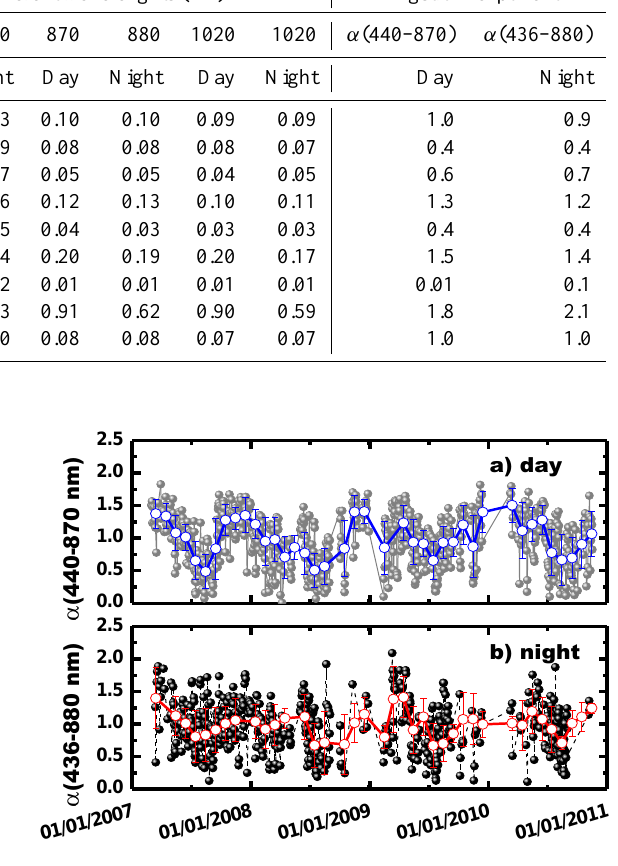
Fig. 2. (a) Temporal evolutions of daytime Angstrom exponent α (440–870 nm) and (b) nighttime Angstrom exponent α (436–880 nm). Fully circles linked by dash lines corresponds to day/night Figure 2: Temporal evolutions of daytime Angström exponent α(440-870 nm) (a) and nighttime mean values, while open circles linked by solid lines represents Angström exponent α(436-880 nm) (b). Fully circles linked by dash lines corresponds to monthly day/night values and their standard deviations. All the data day/night mean values, while open circles linked by solid lines represents monthly day/night were acquired at Granada from 2007 to values and their standard deviations. All the data were acquired at Granada from 2007 to 2010.